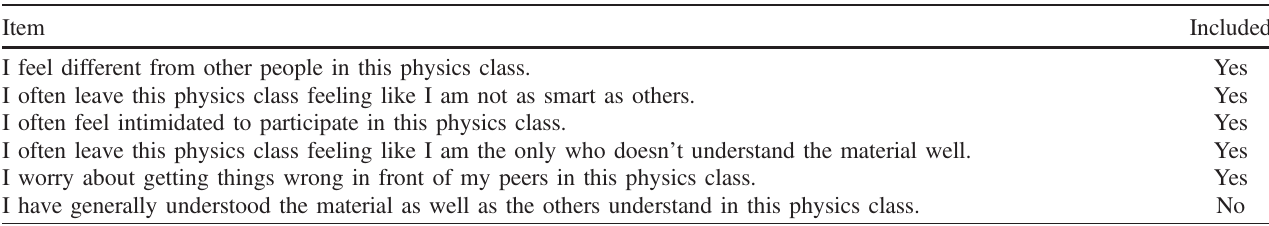
TABLE II. Original social comparison concern survey items and an indication of items included in this study. Item